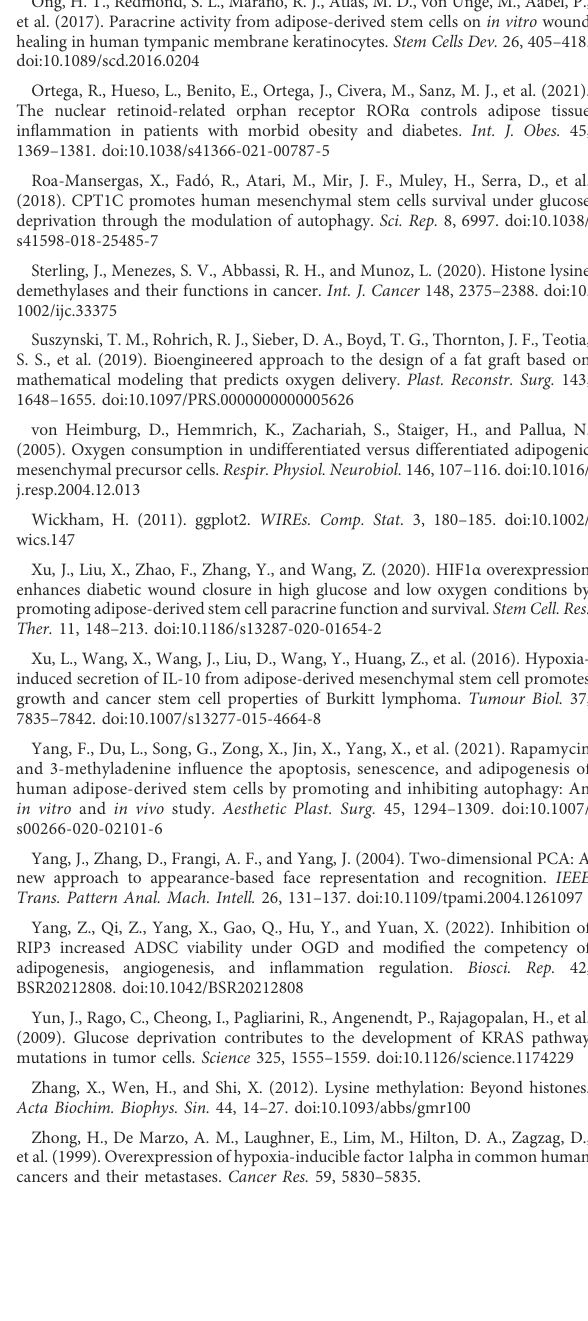
SUPPLEMENTARY FIGURE S1 GeneexpressionchangesintheHIF-1signallingpathway.Representation of the differentially expressed genes that were enriched in the HIF-1 signalling pathway (KEGG: hsa04066). Red boxes indicate the differentially expressed genes. SUPPLEMENTARY FIGURE S2 Gene expression changes in the IL-17 signalling pathway. Representation of the differentially expressed genes that were enriched in the IL-17 signalling pathway (KEGG: hsa04657). Red boxes indicate the differentially expressed genes.